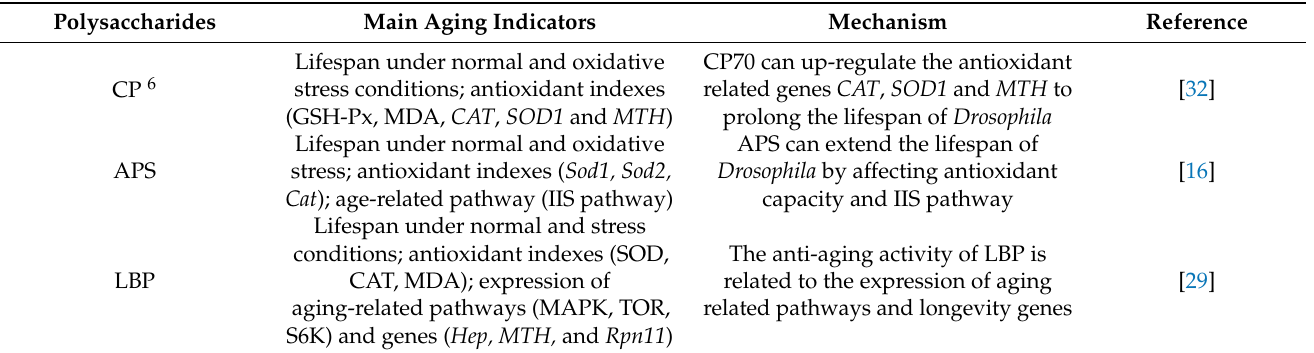
Table 2. Anti-aging study of polysaccharides using Drosophila as a